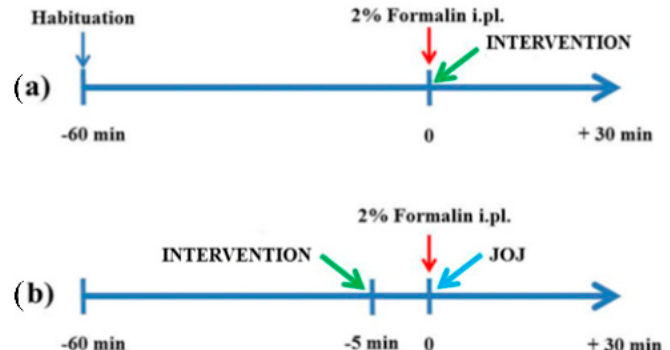
Figure 1. Experimental protocol. ( a ) posttreatment; ( b ) pretreatment. Schedule of transdermal administration of the intervention (essential oil of bergamot and its fractions and main pharmacologically active components) or of the vehicle (Jojoba oil, JOJ) during the time course of the formalin test.